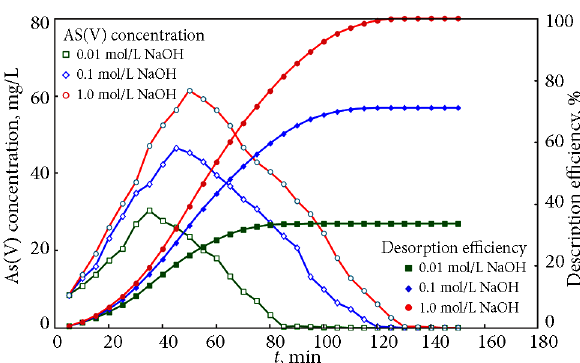
Figure 12. Effect of eluent concentration on the As(V) desorption efficiencies (flow rate: 5.136 mL/min; adsorbent mass: 2 g; adsorbent grain size: <100 mesh; operating temperature: 35